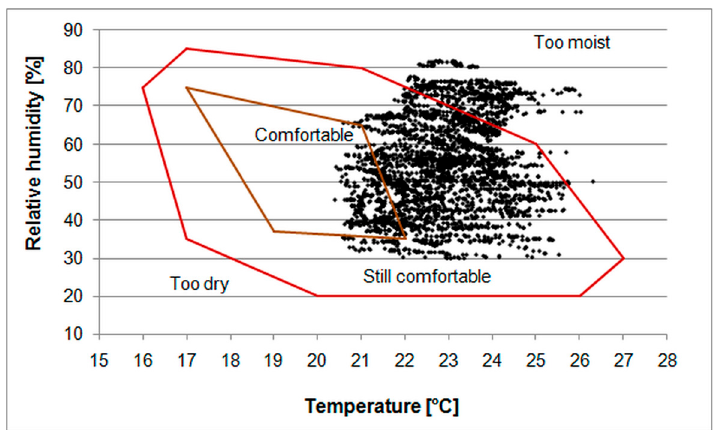
Figure 19. Internal air temperature and relative humidity against the comfort zones of Leusden and Freymark.